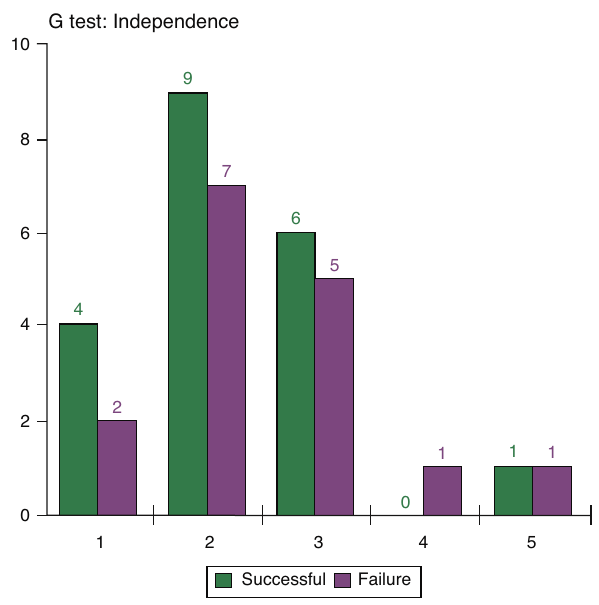
Correlation between the number of dilatations and balloon laryngoplasty success. No statistical